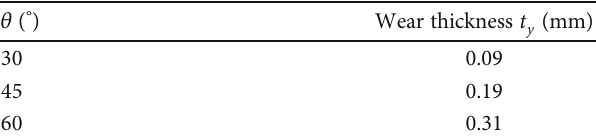
Table 8: Wear thickness corresponding to di ff erent θ .